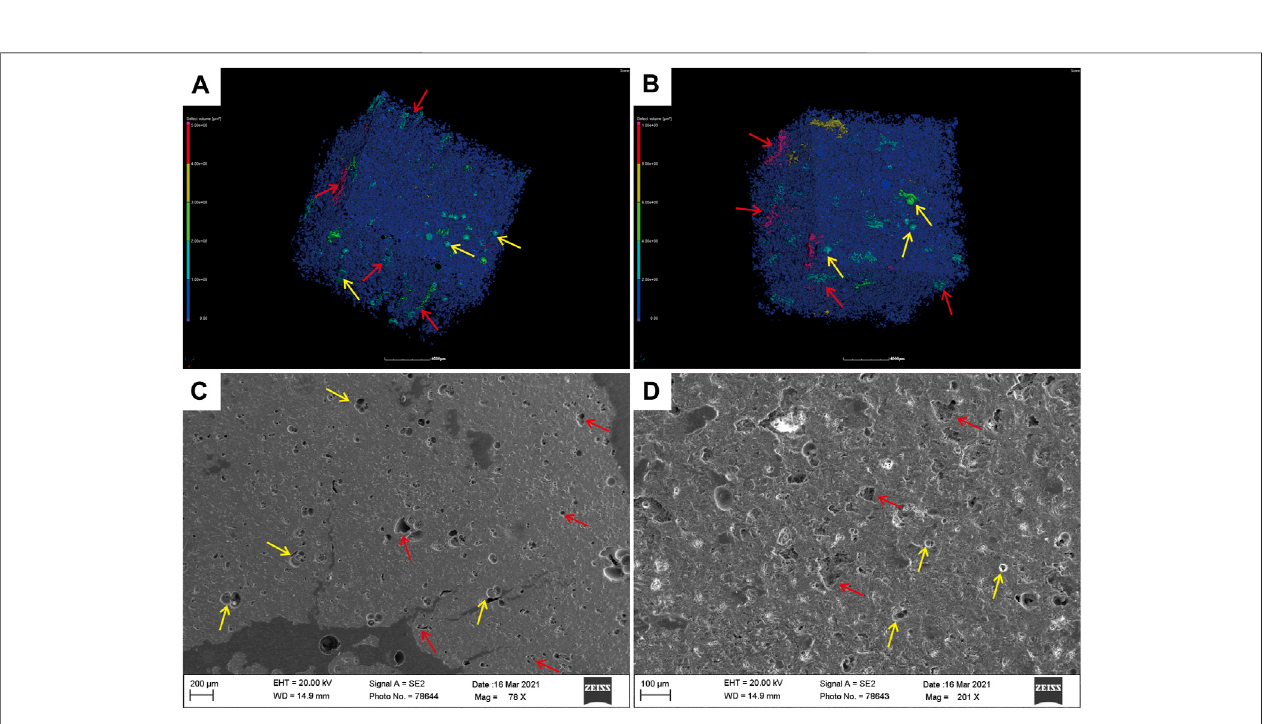
FIGURE7| Microstructureofsedimentsin the Ⅰ -GHR layer. (A) SiteW19, 137.60mbsf, CTscan image; (B) Site W19, 138.60mbsf, CTscanimage; (C) Site W19, 130.70 mbsf, SEM image; (D) Site W19, 138.60 mbsf, SEM image; red arrows indicate CG-intergranular pores, yellow arrows indicate BG-pores.